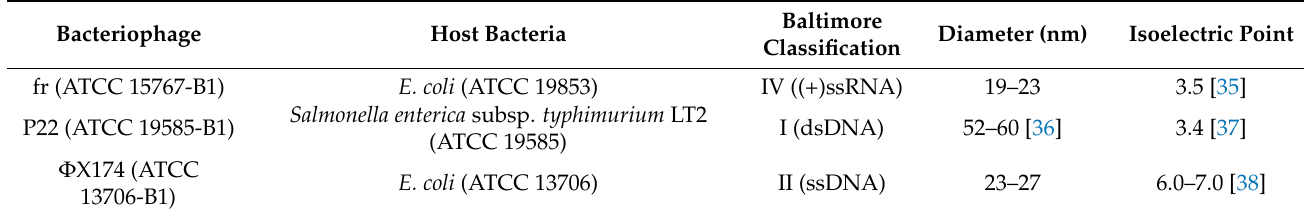
Table 1. Properties of bacteriophages used in this study, adapted from Mayer et al. [34] or as cited. Baltimore Diameter (nm) Isoelectric Point Bacteriophage Host Bacteria Classification fr (ATCC 15767-B1) E. coli (ATCC 19853) Salmonella enterica subsp. typhimurium LT2 P22 (ATCC 19585-B1) (ATCC